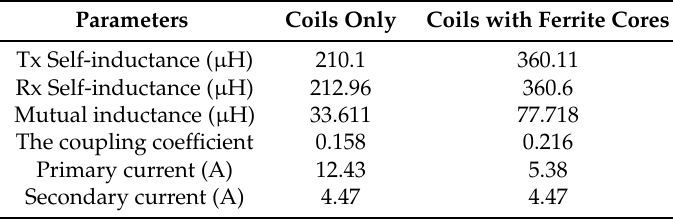
Table 2. The simulation design results for coils and coils with cores.